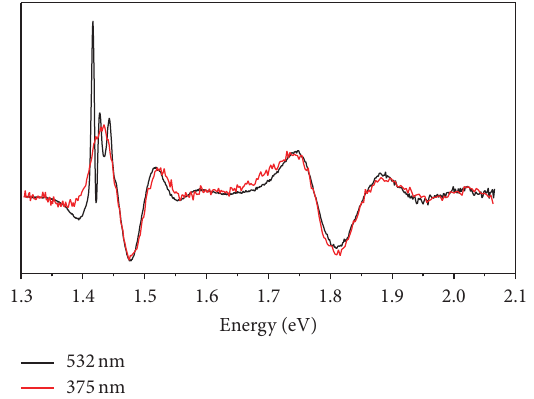
Figure 2: PR spectra of M1 heterostructure obtained with 532 nm (black line) and 375 nm (red line) lasers as modulation source.